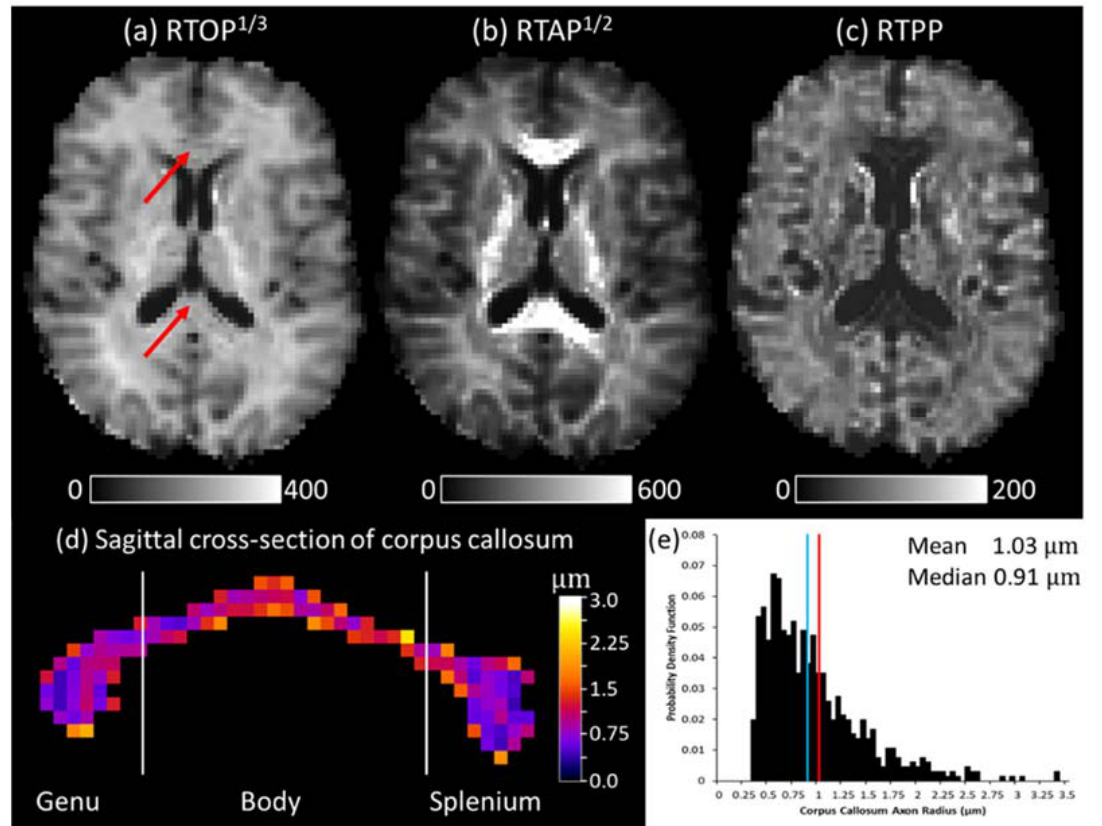
Figure 5. Quasi-diffusion mean apparent propagator imaging results for a young, healthy subject (age 27 years). The top row shows axial slices through ( a ) √𝑅𝑇𝑂𝑃 (cid:3119) , ( b ) √𝑅𝑇𝐴𝑃 , and ( c ) 𝑅𝑇𝑃𝑃 maps. The bottom row shows ( d ) effective pore radius estimates in a cross-section through the mid-sagittal plane of the corpus callosum, and ( e ) a probability density function of micron radii for the analysed 10 mm thick section of the corpus callosum (graph ( e )). The location of the corpus callosum is identified by red arrows. The red and blue lines in graph ( e ) indicate the mean and median, respectively.